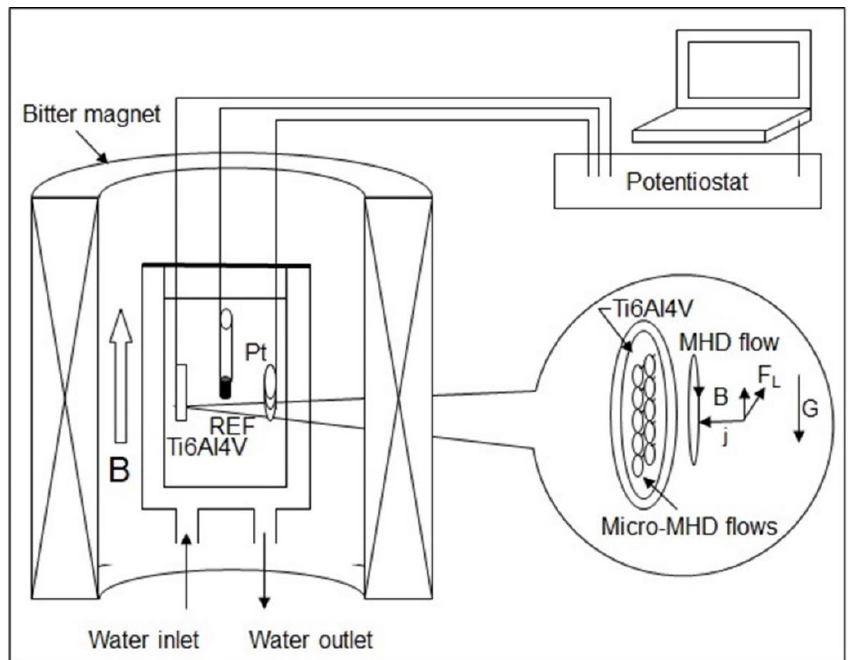
Figure 1. The schematic experimental apparatus.